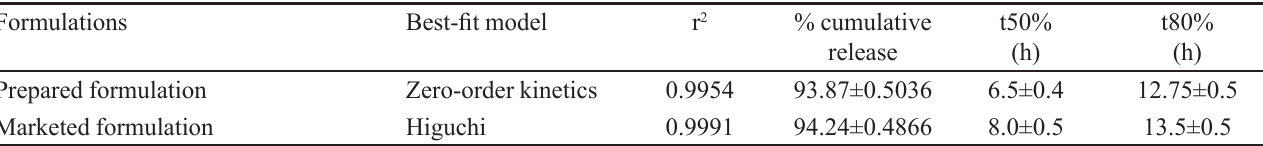
TABLE VII - Kinetic models showing drug release pattern of formulated and marketed formulation Formulations